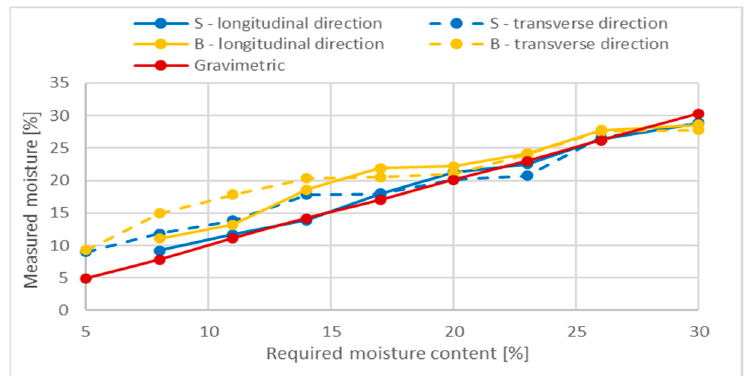
Figure 6. Dependence of the average measured values of MC using the Testo 606-2 moisture meter on the MC of different types of wood (S—spruce, B—beech) and in different directions in the MC range of 5% to 30%.